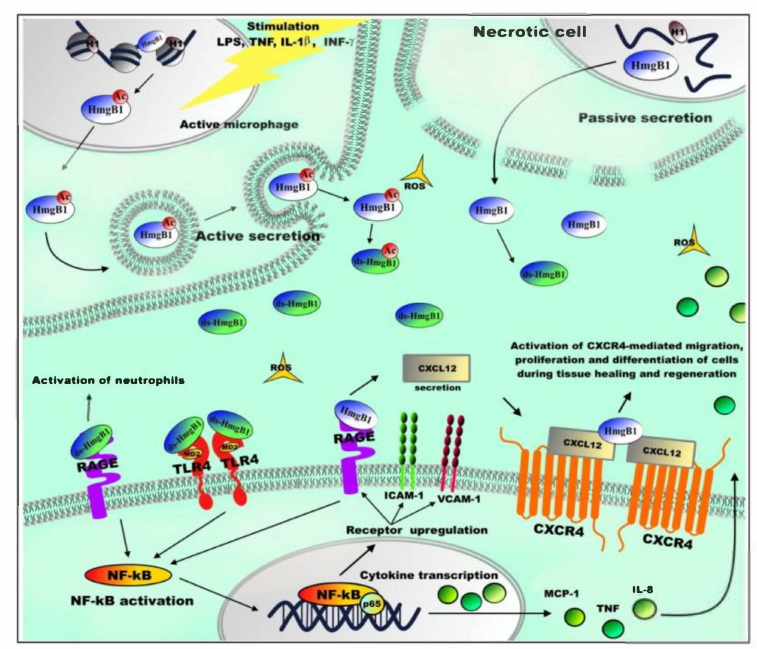
Figure 4. Extranuclear functions of HmgB1.The tumor necrosis factor (TNF), lipopolysaccharide (LPS), or interferon gamma (INF- γ ) stimulation leads to acetylation of HmgB1 in NLS regions and results in the transport of protein from nucleus to cytoplasm and extracellular space. In the extracellular space the HmgB1 is oxidized to ds-HmgB1 by reactive oxygen species (ROS). The functions of ac-ds-HmgB1 are still unclear. In case of disturbance of cell integrity, non-acetylated HmgB1 is released to the extracellular space. Depending on the REDOX state, HmgB1 can act as signal molecule (by activation the signaling pathways of MAPKs, NF-kB, and phosphoinositide 3-kinase / AKT), take part in regulation of cell migration, or participate in immune response and in the synthesis of anti-inflammatory